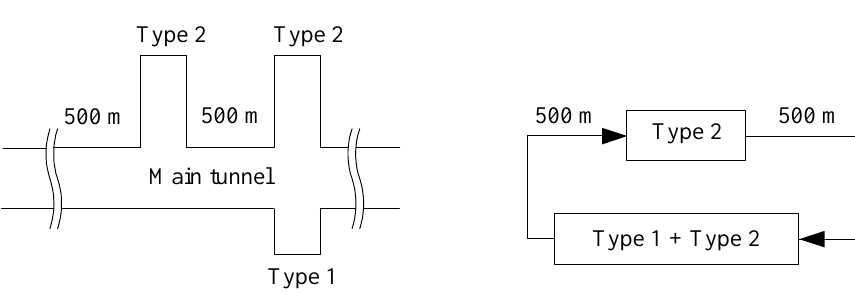
Fig. 4 Arrangement of short side branches for numerical simulations.